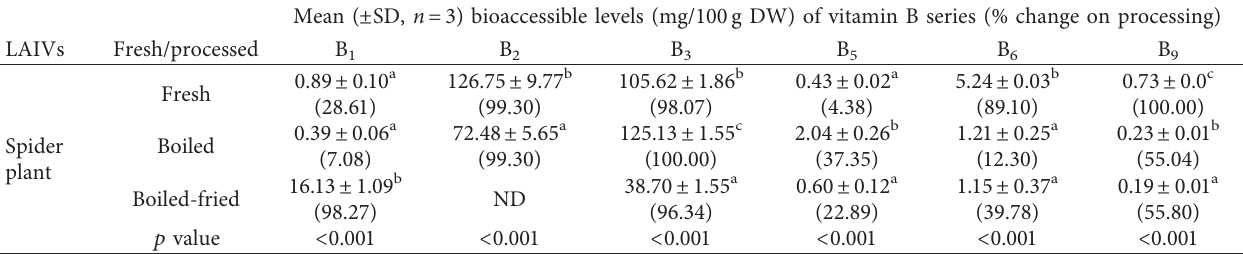
Table 3: Mean bioaccessible levels of vitamin B series in fresh and processed LAIVs and the percent change with in vitro digestion.